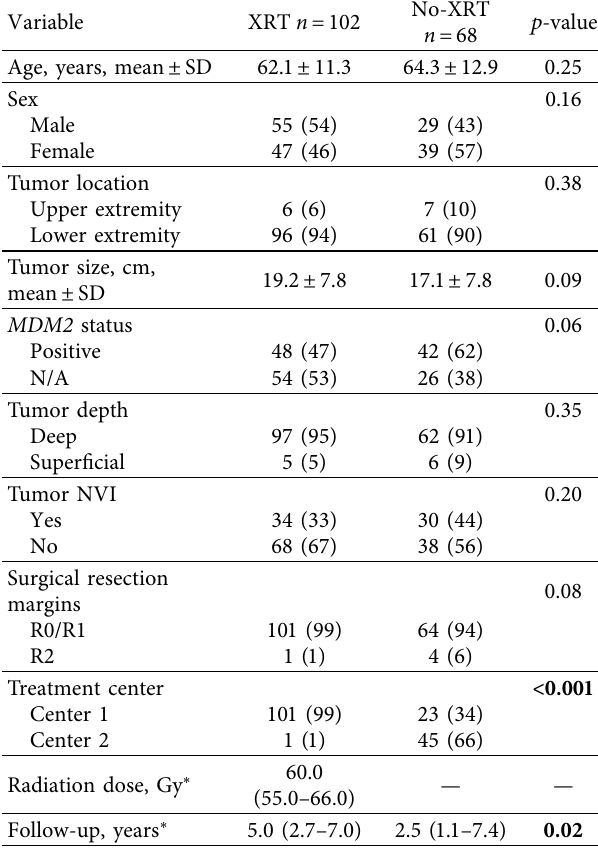
Table 1: Patient, tumor, and treatment